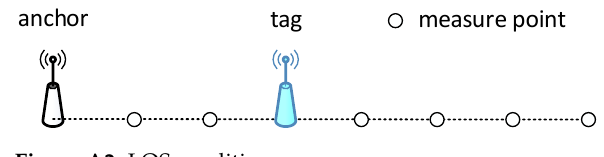
Figure A2. LOS conditions.